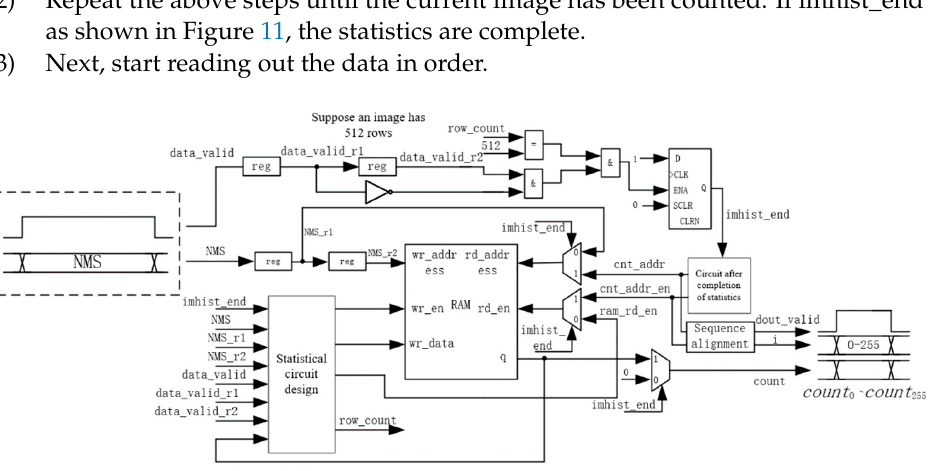
Figure 11. Histogram architecture.